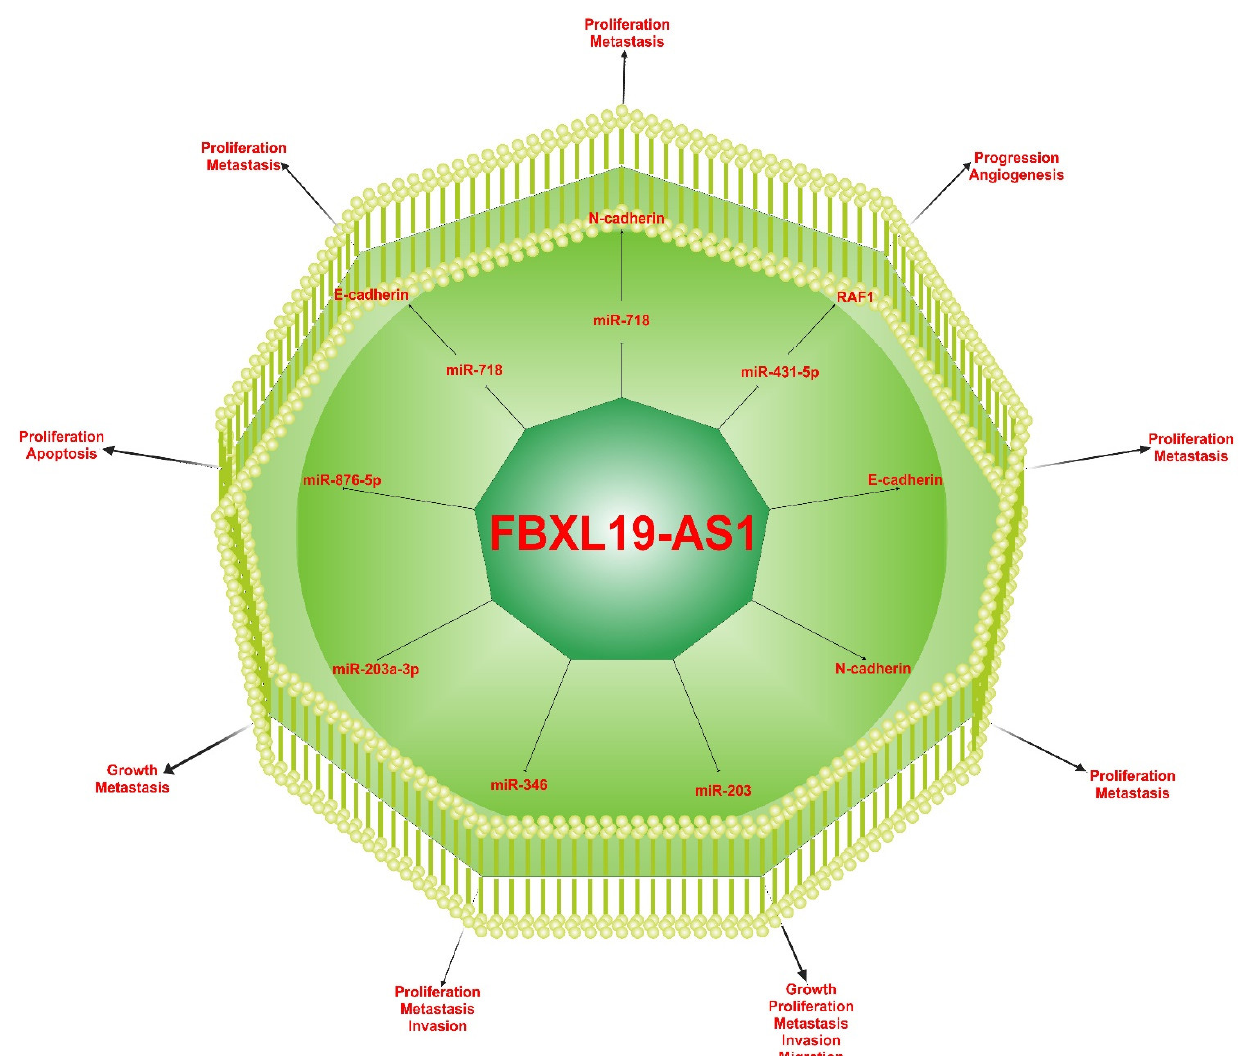
Figure 6. Underling molecular mechanisms of FBXL19-AS1.